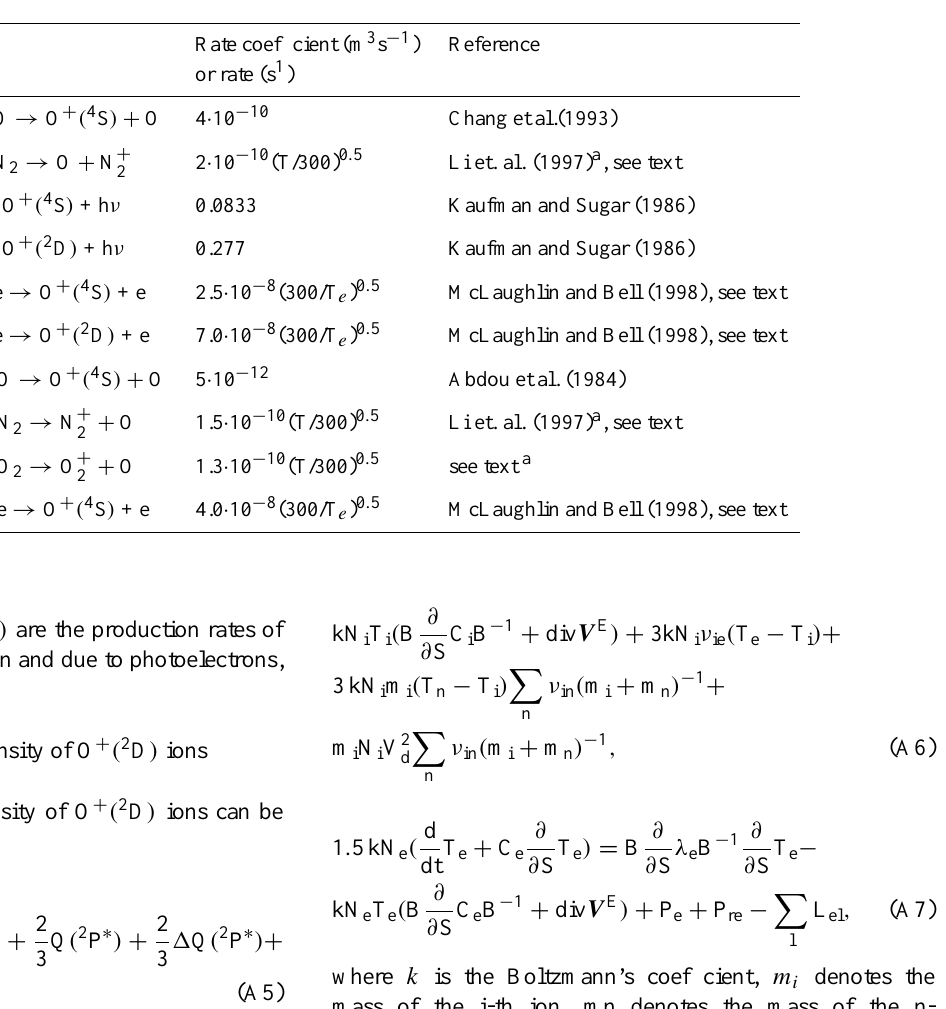
Table A1. Chemistry of O + ( 2 D ) and O + ( 2 D ) ions ( a The effective temperature T = ( m i T n + m n T i )( m i + m n ) − 1 + m i m n V 2 where m i and m n denote the masses of ion and neutral reactants, respectively, V d is a plasma drift